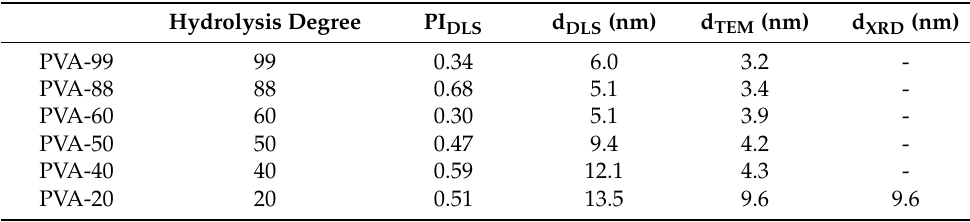
Table 6. Comparison between poly-dispersity index (PI), DLS, XRD, and TEM diameter of gold nanoparticles obtained using PVA with different hydrolysis degrees.